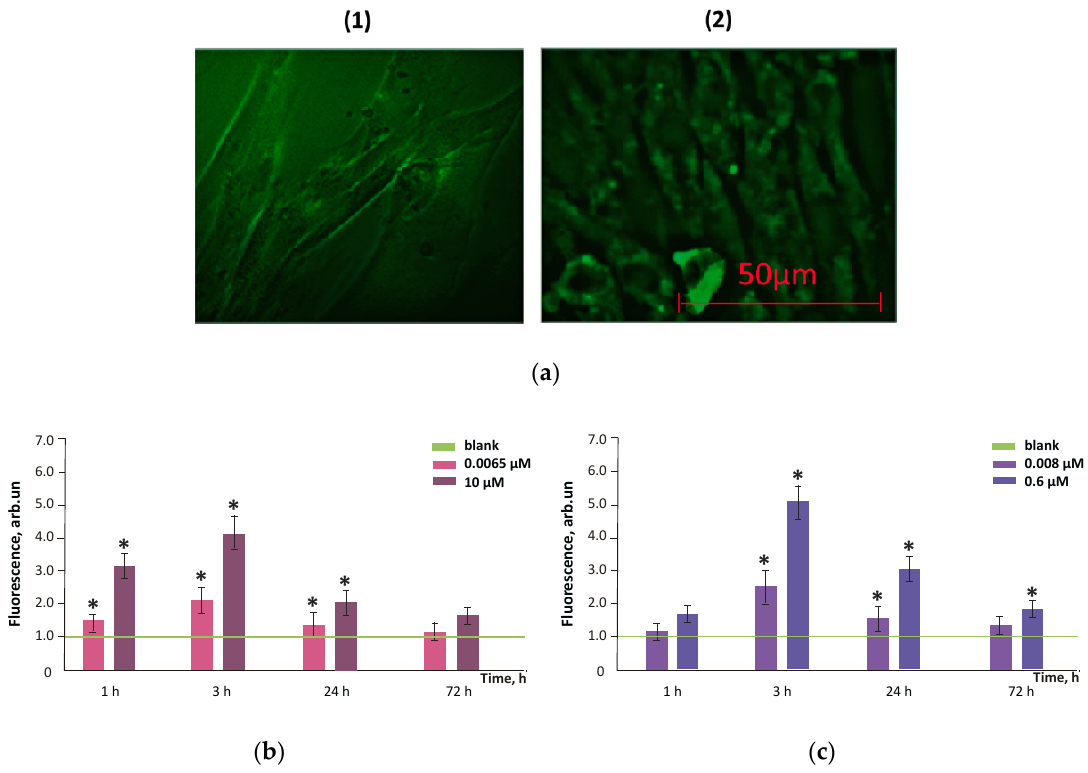
Figure 6. ( a ) FF2 fluorescence (1.3 µ M) in cells during 1 (left) and 3 h (right) of incubation; a 450–525-nm filter; excitation wavelength, 370 nm, magnification, × 40; accumulation of FF1 ( b ) and FF2 ( c ) in the cells depending on incubation time determined with flow cytometry, concentrations are given in figure; (*) means that the results di ff er significantly from the blank (cells cultured without the fullerenes) according to the Mann–Whitney test ( p <